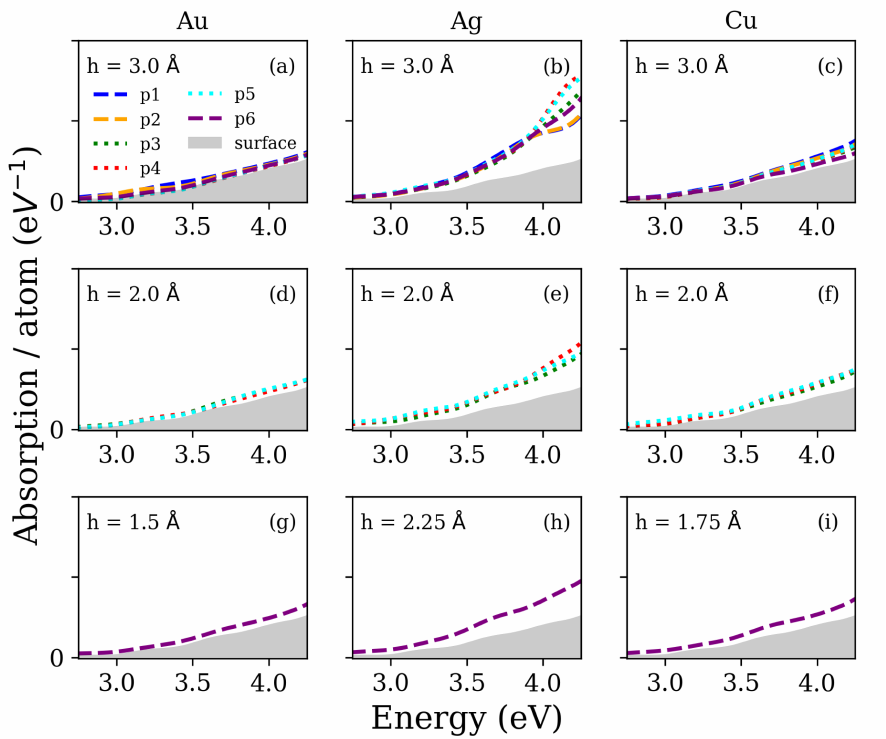
Figure 3. Photo-absorption spectra of Au (first column ( a , d , g )), Ag (second column ( b , e , h )), and Cu (third column ( c , f , i )) surface structures for suspended Me s (first row ( a – c )), between suspended & bonded Me s (second row ( d – f )), and bonded Me s (third row ( g – i )). The gray area shows the absorption of the bare TiO 2 (110) surface. Blue, yellow, green, red, cyan, and purple indicate adsorption positions from p1 to p6, respectively. The dashed lines represent Me s located around O b ; the dotted lines represent the Me s located far from O b